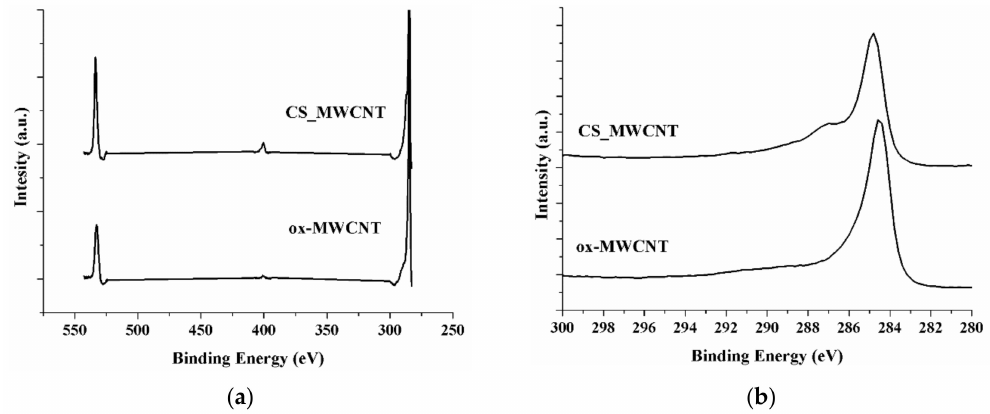
Figure 2. ( a ) XPS survey spectrum of ox-MWCNT, and CS_MWCNT; ( b ) XPS C 1 s binding energy curves of ox-MWCNT, and CS_MWCNT.